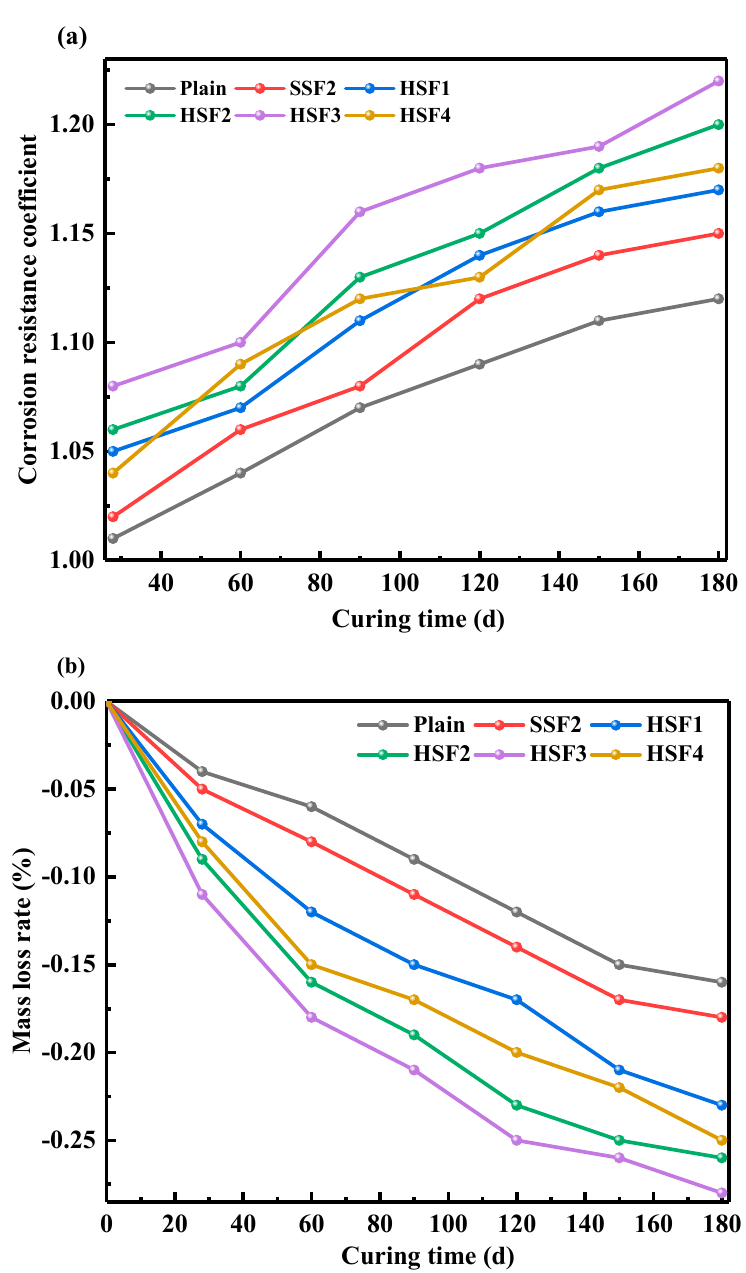
Figure 10. Corrosion resistance coefficient and mass loss rate of FRC. Figure 10b shows the mass-loss rate of the specimen at different erosion ages, and the mass-loss rate is negative, indicating that the mass of the specimen increases after sulfate erosion. It can be seen that the mass of the specimens in each group shows an increasing trend with the increase of the erosion age. The mass-growth rates of the Plain group were 0.04, 0.06, 0.09, 0.12, 0.15, and 0.16, and after adding 1.5% MSF, the growth rates of SSF2 were 0.05, 0.08, 0.11, 0.14, 0.17, and 0.18, respectively. After adding mSF fibers, the mass-growth rate of the sample first increased and then decreased with the increase of the mSF content. When the mSF content was 0.3%, and the MSF content was 1.2%, the mass-growth rate of the sample HSF3 reached the maximum, 0.11, 0.18, 0.21, 0.25, 0.26, and 0.28, respectively. This shows that after sulfate corrosion, the specimen’s interior is entered, and a chemical reaction occurs. The specimen generates AFt from the inside to the outside so that the mass will increase. In addition, in the long-term sulfate attack test,